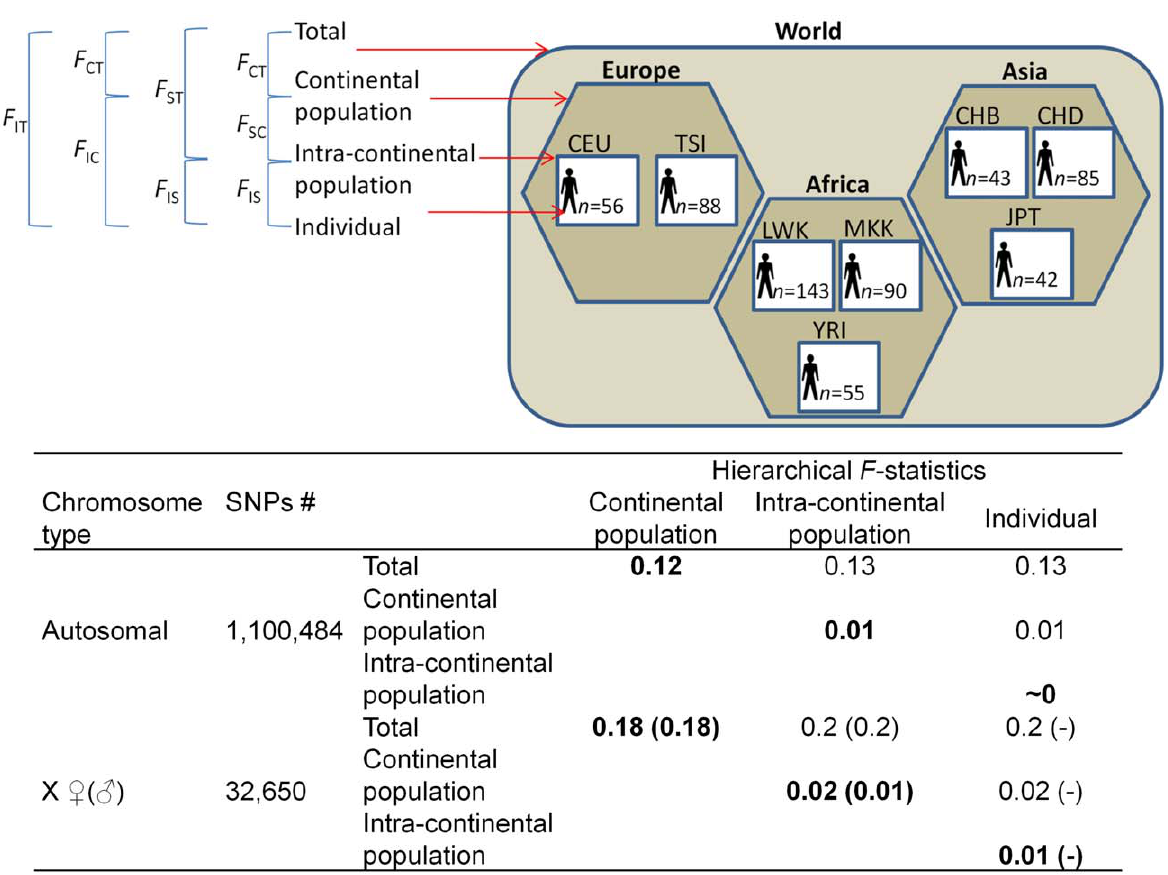
Figure 3. An illustration of a hierarchical F -statistics analysis using eight populations. Samples are organized in a three level structure of individuals, intra-continental populations, and continental populations. The relationships between the six fixation indices are depicted on the top left and follow the formulation of Eq. S1. For example, 1 { F IT ~ (1 { F IC )(1 { F CT ) . Below are the F -statistics, calculated separately for autosomes, male X- chromosomes, and females X-chromosomes. The indices measuring the genetic variation between continental populations ( F CT ), between intra- continental populations ( F SC ), and between individuals of intra-continental populations ( F IS ) are shown in bold.